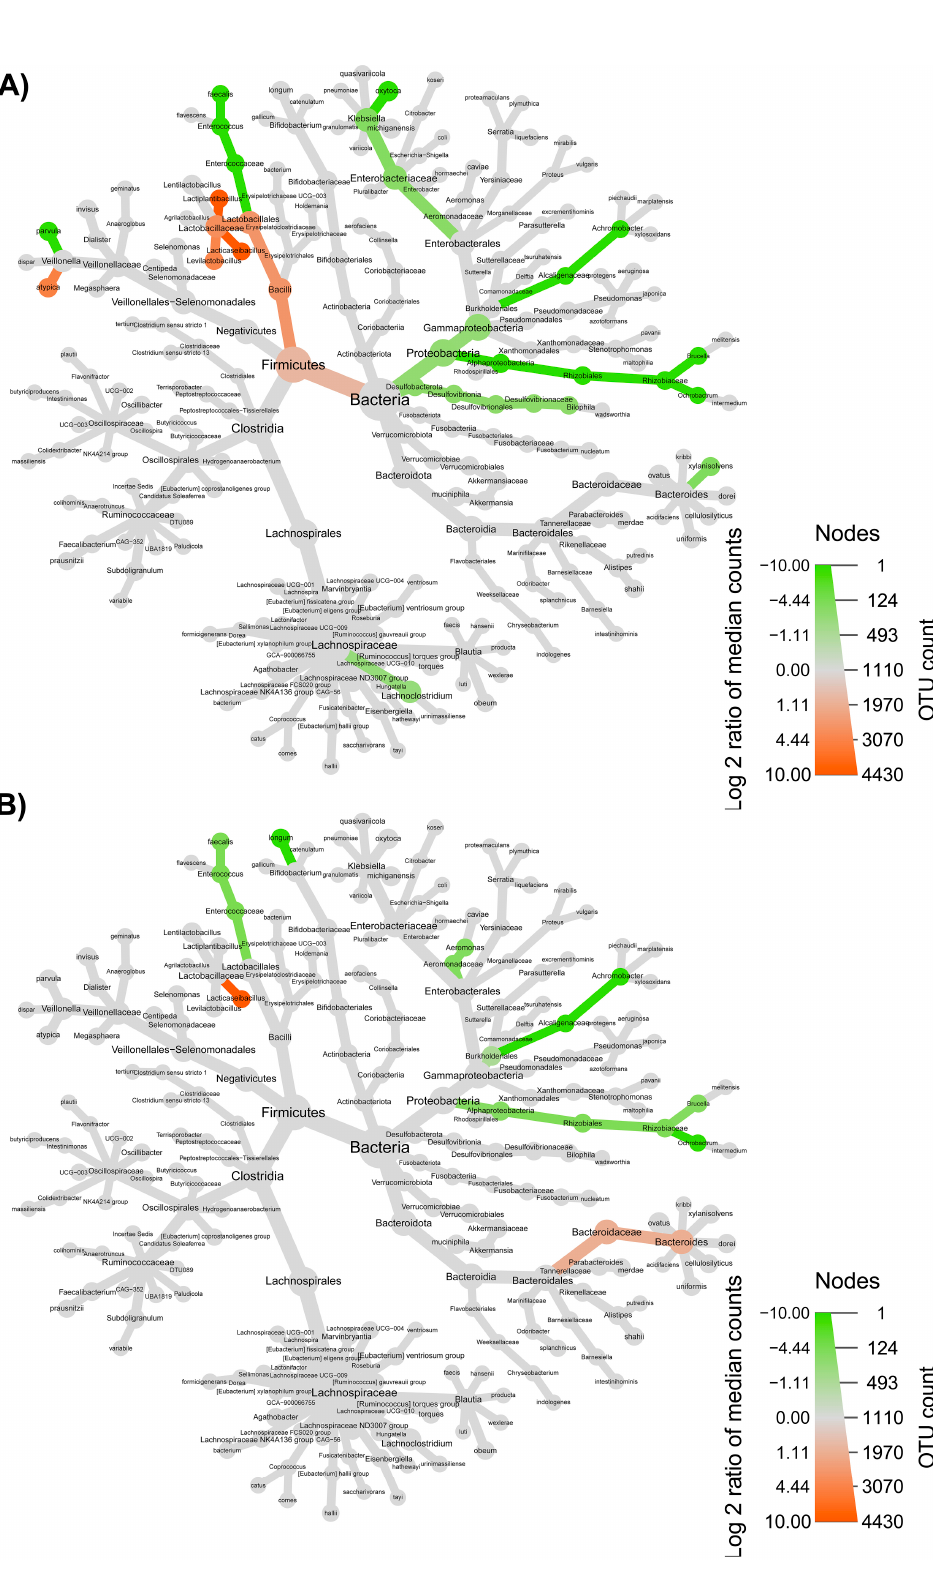
Figure 7. Microbial community taxonomic structure variations at different levels, before compared to after feeding with MRB ( A ), and before feeding against the end of wash out period ( B ). Node size denotes the rarefied ASV count, and colored nodes indicate a significant ( p < 0.05) fold change for a given taxon: green color means that the taxon is differentially abundant before the treatment, while orange color indicates that the taxon is differentially abundant after feeding ( A ) or after wash out period ( B ). Color intensity is proportional to the fold change.